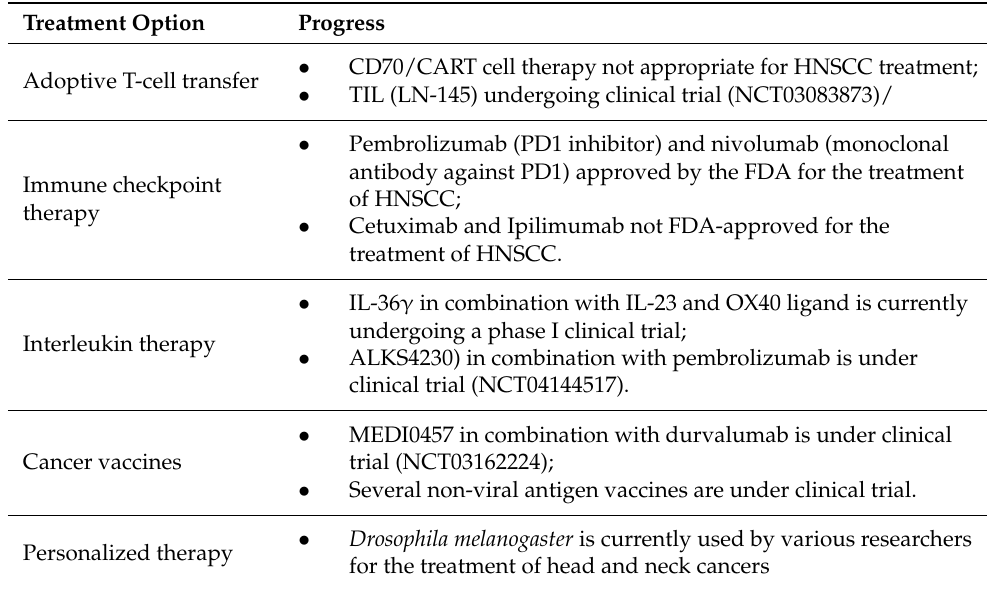
Table 3. Summary of the progress of immunotherapy in head and neck